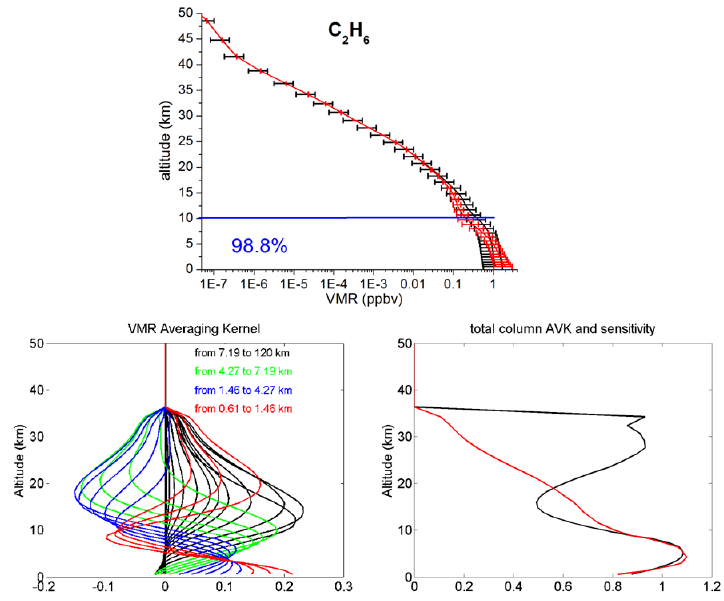
Figure 5. Same as Fig. 3 but for C 2 H 6 . The C 2 H 6 a priori VMR profile is from WACCM v4.5.